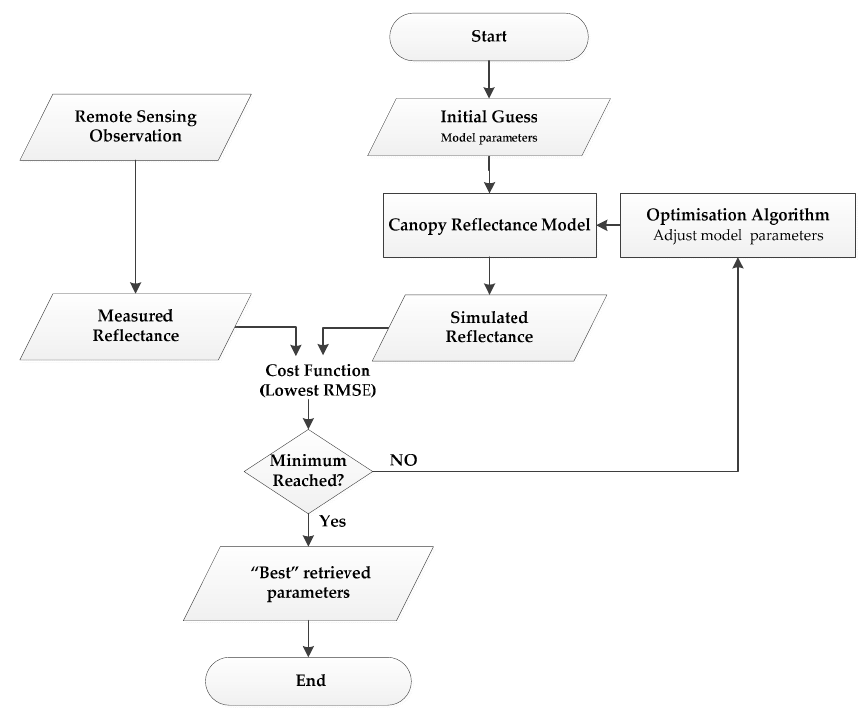
Figure 3. Conceptualization of the iterative optimization technique used in this study.